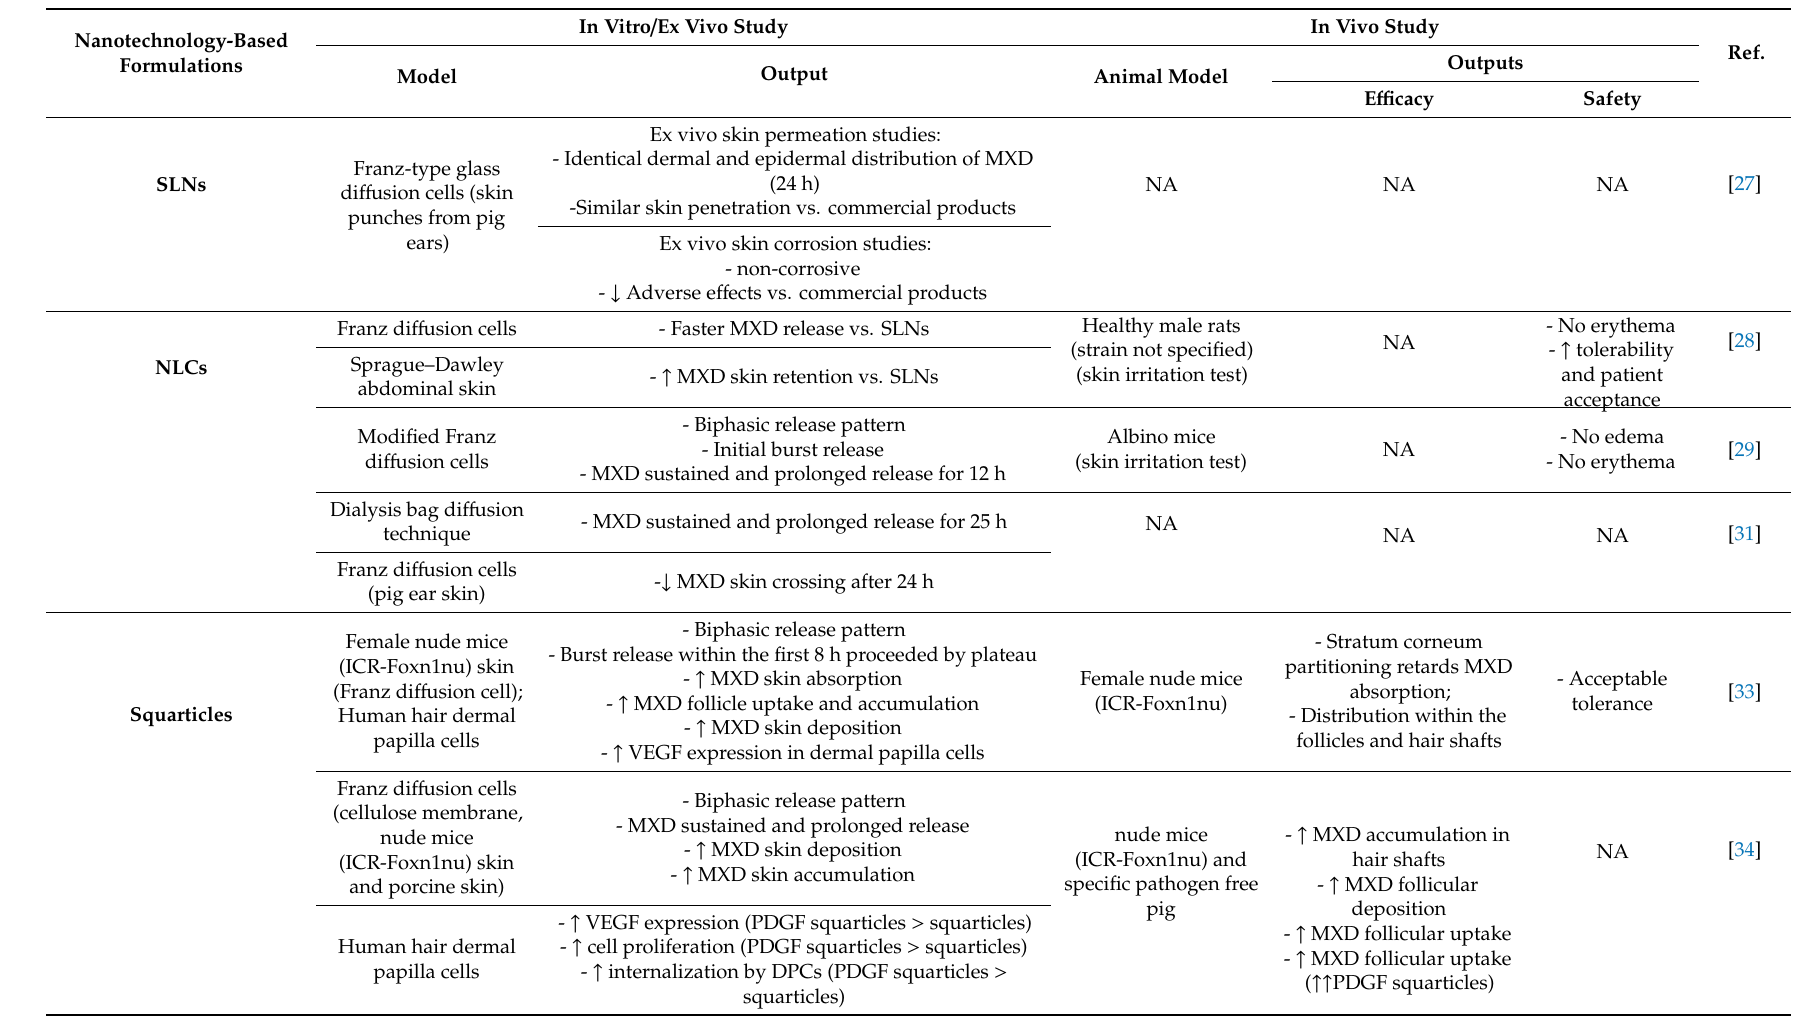
Table 2. In vitro and in vivo results overview of nanotechnology-based formulations for topical administration of minoxidil. Nanotechnology-Based